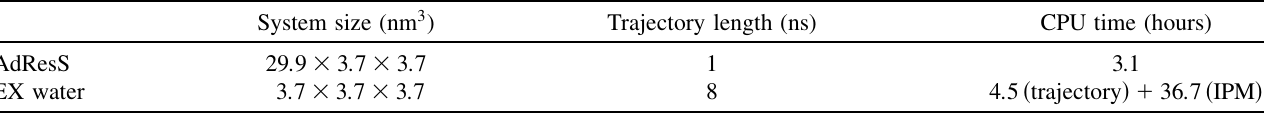
TABLE I. Comparison of computational efficiency. The AdResS simulation contains 13 824 molecules, while the EX water simulations contain 1728 molecules. In the AdResS simulation, the size of the AT þ HY regions ( 6 : 7 (cid:4) 3 : 7 (cid:4) 3 : 7 nm 3 ) is even larger than that of the EX water simulation box, so that we are actually in a worst-case-scenario situation. Moreover, simulations with smaller reservoirs give essentially the same results reported for this system. ‘‘System size’’ means the size of the box used in the simulation. ‘‘Trajectory length’’ means the equilibrium trajectory used for the particle insertion in the IPM approach. Along the trajectories, frames of configurations are recorded every 0.2 ps. ‘‘CPU time’’ is the wall clock time spent on the simulation. For the particle insertion simulation, the CPU time is counted in two parts: the time of generating the equilibrium trajectories (not expensive) and the time required by the IPM procedure (very expensive). Moreover, not only is the insertion procedure itself expensive, but even after 8 ns the insertion process has not actually converged. Simulations on longer time scales show that the full convergence is actually never reached, which suggests that the insertion procedure for a molecule as simple as water is not fully rigorous from the physical point of